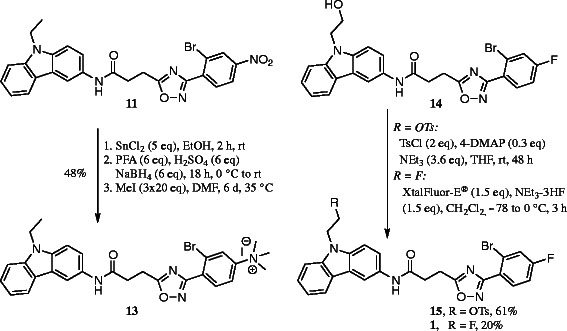
Synthesis of precursors 13 and 15 and reference compound 1. SnCl2, tin(II) chloride; PFA, paraformaldehyde; MeI, methyl iodide; 4-DMAP, 4-dimethylaminopyridine; XtalFluor-E®, diethylaminodifluorosulfonium tetrafluoroborate; NEt3-3HF, triethylamine trihydrofluoride.